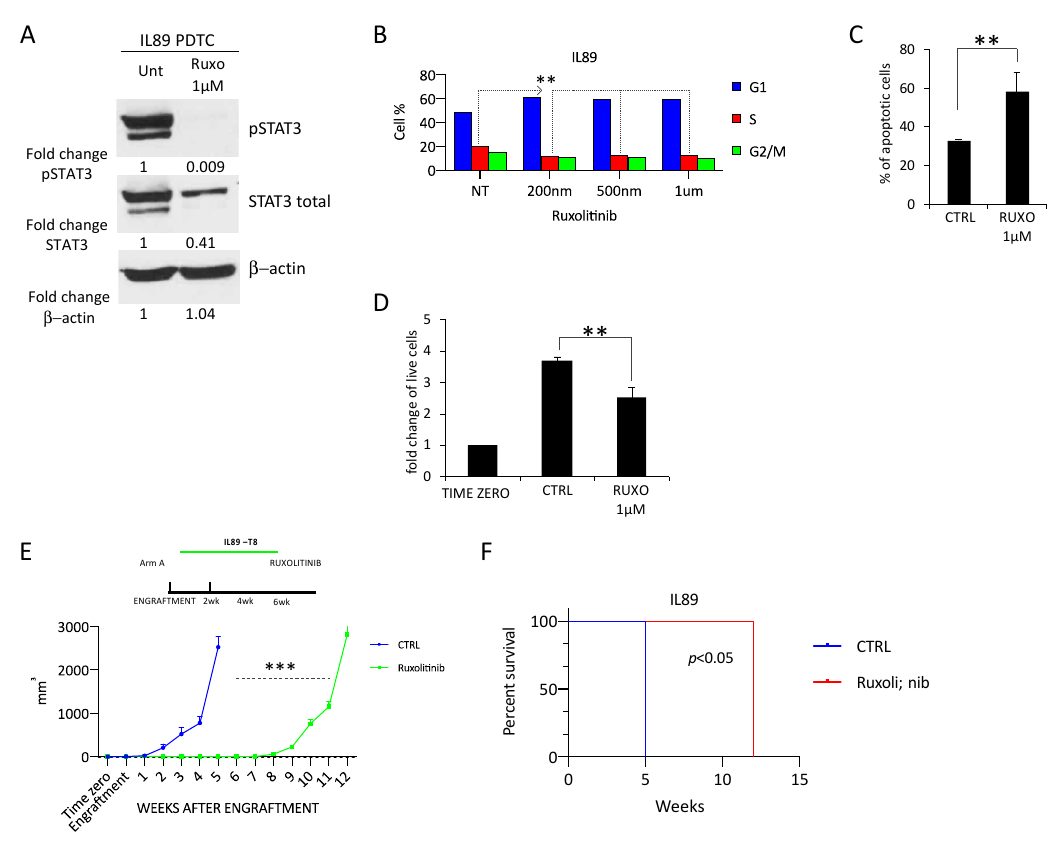
Figure 4. IL89 response to ruxolitinib treatment in vitro and in vivo. ( A ) Ruxolitinib treatment (72 h and1 µ M) in IL89 patient-derived tumor cells (PDTC) resulted in a decrease of STAT3 phosphorylation and cell cycle arrest ( B ), an increase of the apoptotic rate ( C ), and a reduction of the cell number ( D ) in vitro. In vivo treatment with ruxolitinib (chow ad libitum) of IL89 PDTX mice determined a strong decrease of tumor growth ( E ) and an increased overall survival ( F ). Data are representative of at least three independent experiments and values are expressed as the average ± standard deviation. p -values were calculated using the student t -test. ** p < 0.01, *** p < 0.001, A log-rank test was used to calculate the p -value in ( F ).